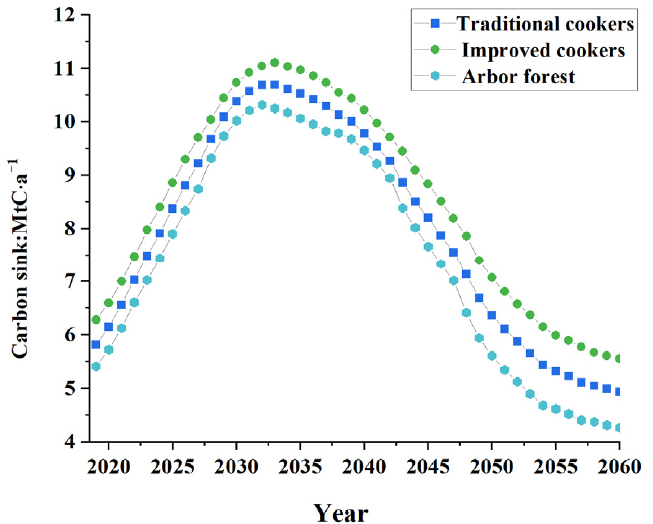
Figure 10. Carbon sink of tree forest vegetation in Henan Province under the replacement effect of bioenergy, 2019–2060.